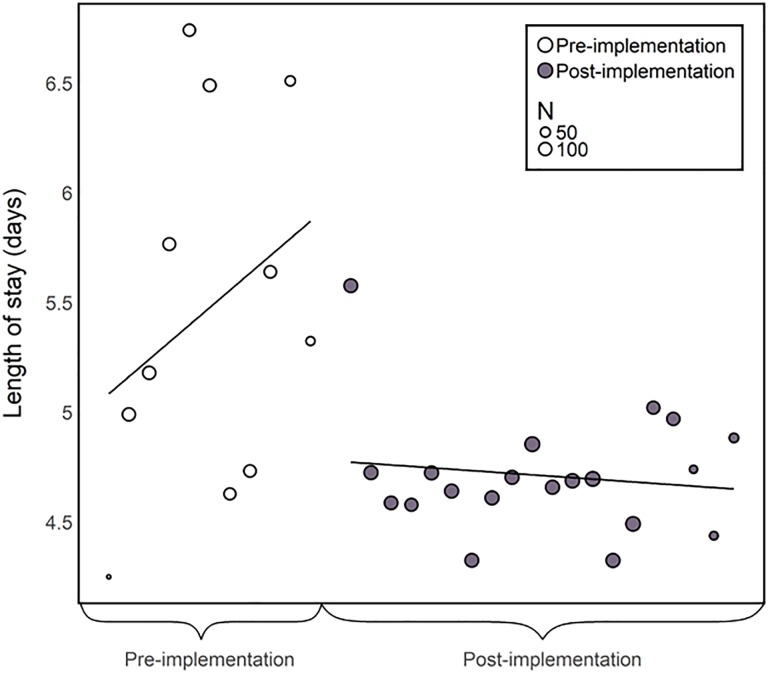
Mean length of stay.